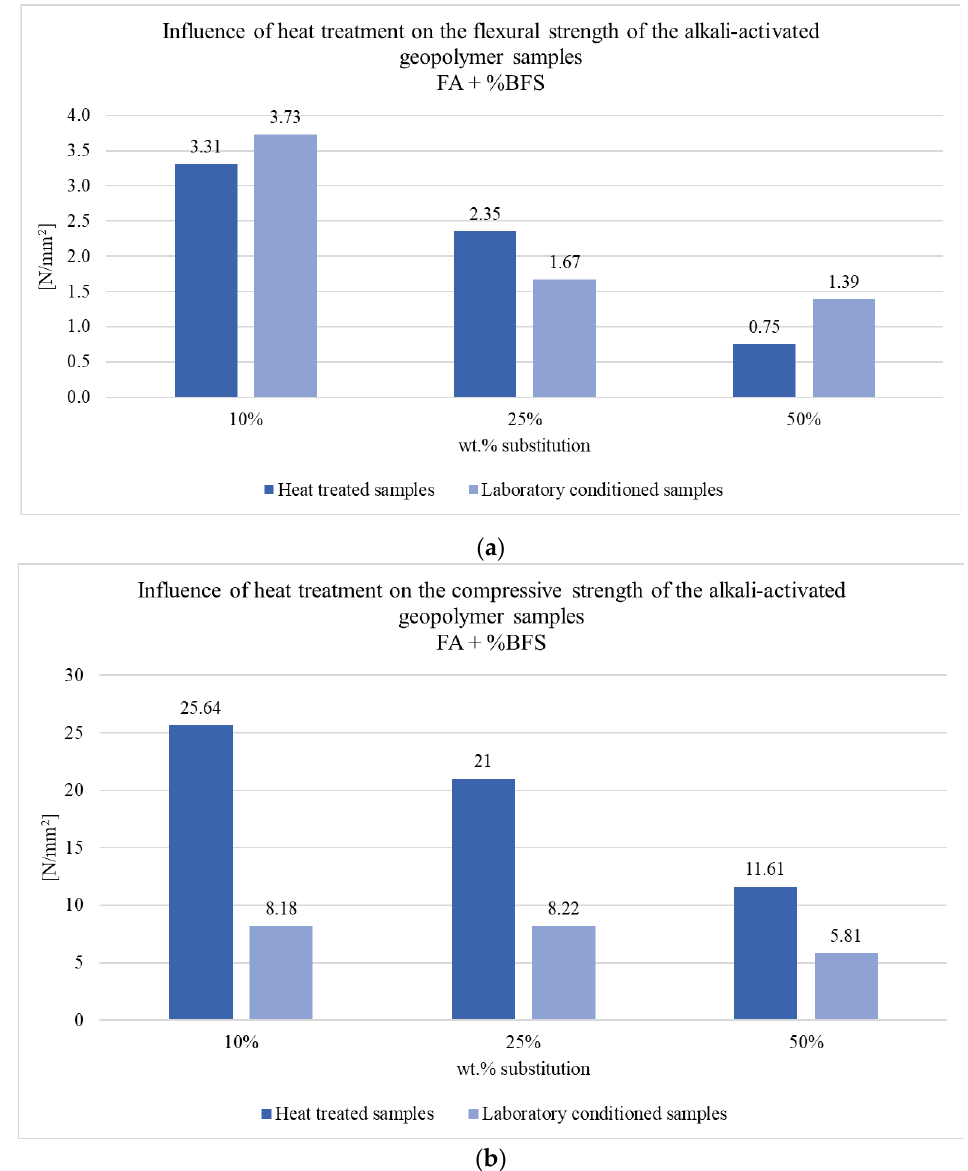
Figure 6. Influence of heat treatment on the mechanical properties of alkali activated geopolymer samples produces using blast furnace slag as fly ash substitution: ( a ) Flexural strength and ( b ) Compressive strength.